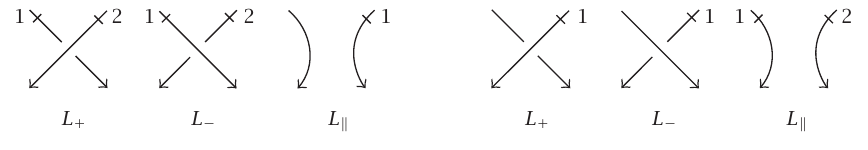
Figure 2.1 . Skein triples of ordered based